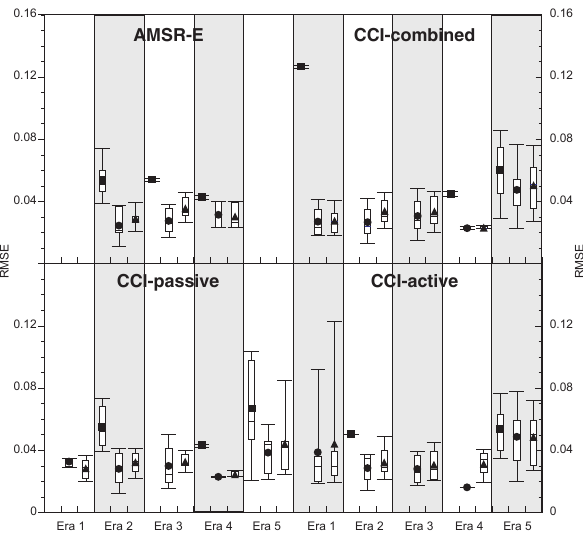
Figure 9. Box plots depicting the RMSE metric for the SNOTEL network. Symbols are the same as in Fig.